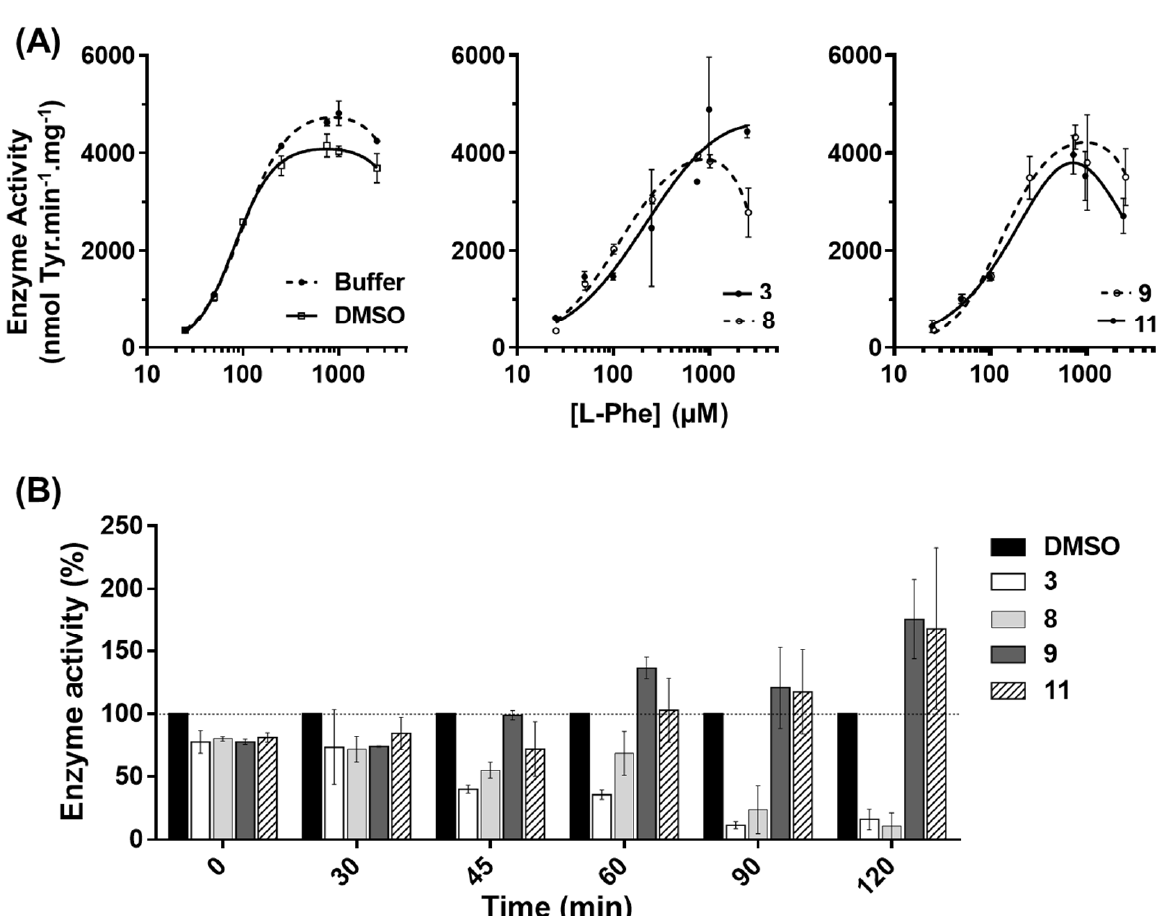
Figure 4. Effect of selected 3HQ derivatives on human phenylalanine hydroxylase (hPAH) catalytic response to increasing concentrations of L -Phe and enzyme activity resistance to thermal inactivation. ( A ) The hPAH activity was assayed at standard conditions (25 to 2500 µ M L -Phe, 75 µ M BH 4 and 25 ◦ C) in the presence of reaction buffer, 1% DMSO and 100 µ M of compounds 3 , 8 , 9 , and 11 ; data represent mean ± SD of three assays; data were fitted to the modified equations of Hill [18] (Equation (1)) or Michaelis–Menten (Equation (2)) accounting for substrate inhibition or the non-modified Michaelis–Menten equation. ( B ) Time-dependent thermal inactivation profile of hPAH in the absence and presence of selected 3HQ derivatives; residual enzymatic activity was determined after 30, 45, 60, 90, and 120 min pre-incubation at 42 ◦ C in the presence of 1% DMSO (control) and 100 µ M of selected compounds; the enzyme activity obtained for compounds 3 , 8 , 9 , and 11 were compared with the activity obtained for the control sample (1% DMSO) for each incubation time, which was considered 100%. Data represent the mean ± SD from three independent assays.